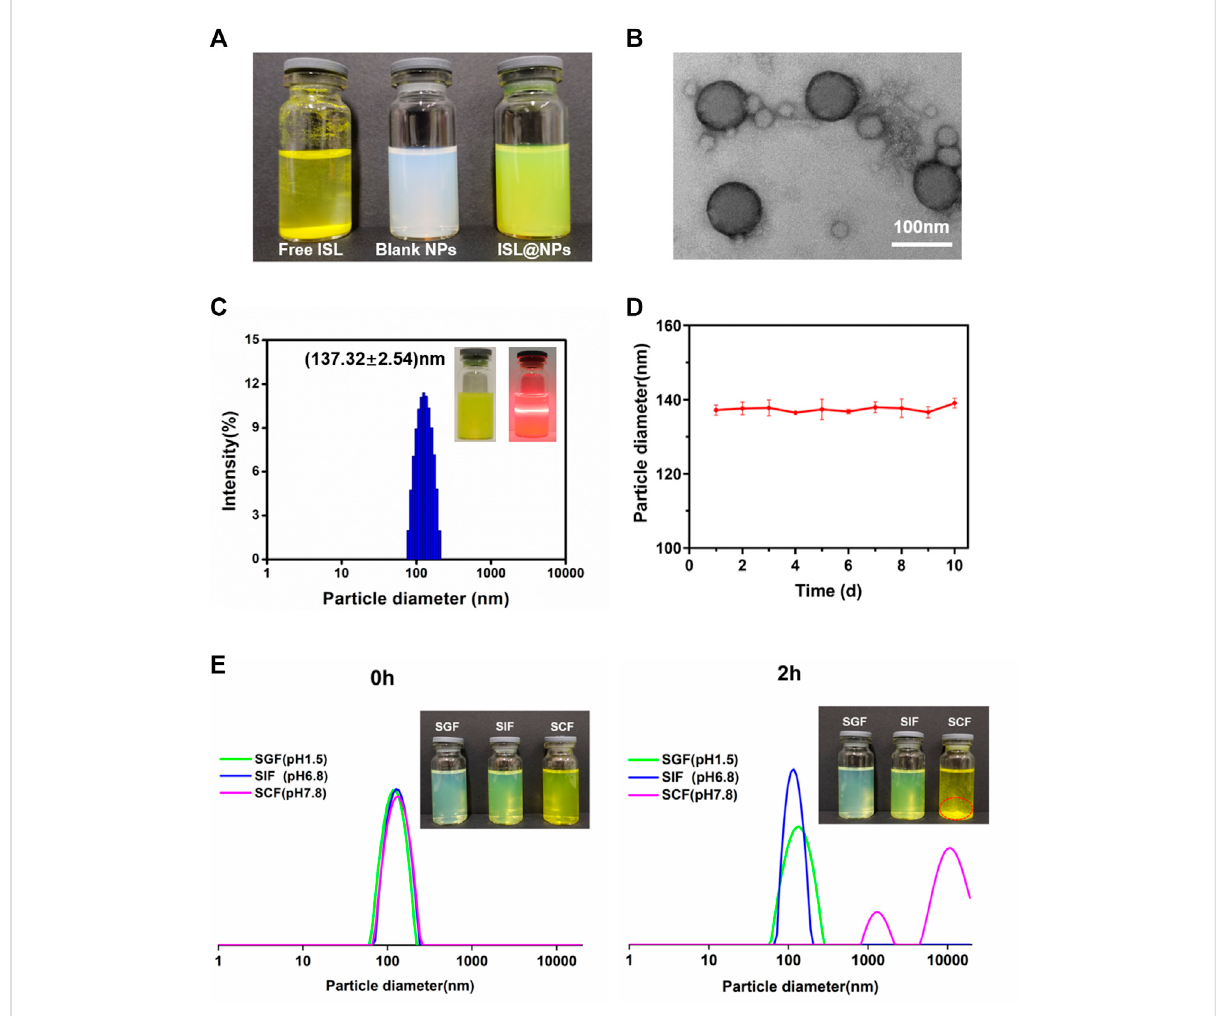
FIGURE 1 CharacterizationofISL@NPs. (A) TheappearanceofhomogeneoussuspensionofISL@NPs,incomparisontotheinsolubilityoffreeISLinwater. (B) TEM image of ISL@NPs. (C) Particle diameter distribution of ISL@NPs by DLS measurement. Tyndall effect could be observed in ISL@NPs. (D) The storage stability of ISL@NPs at 4 ° C for 10 d (E) ISL@NPs exhibited pH-responsive instability in SCF (pH 7.8), in comparison to the stability in SGF (pH 1.5) and SIF (pH